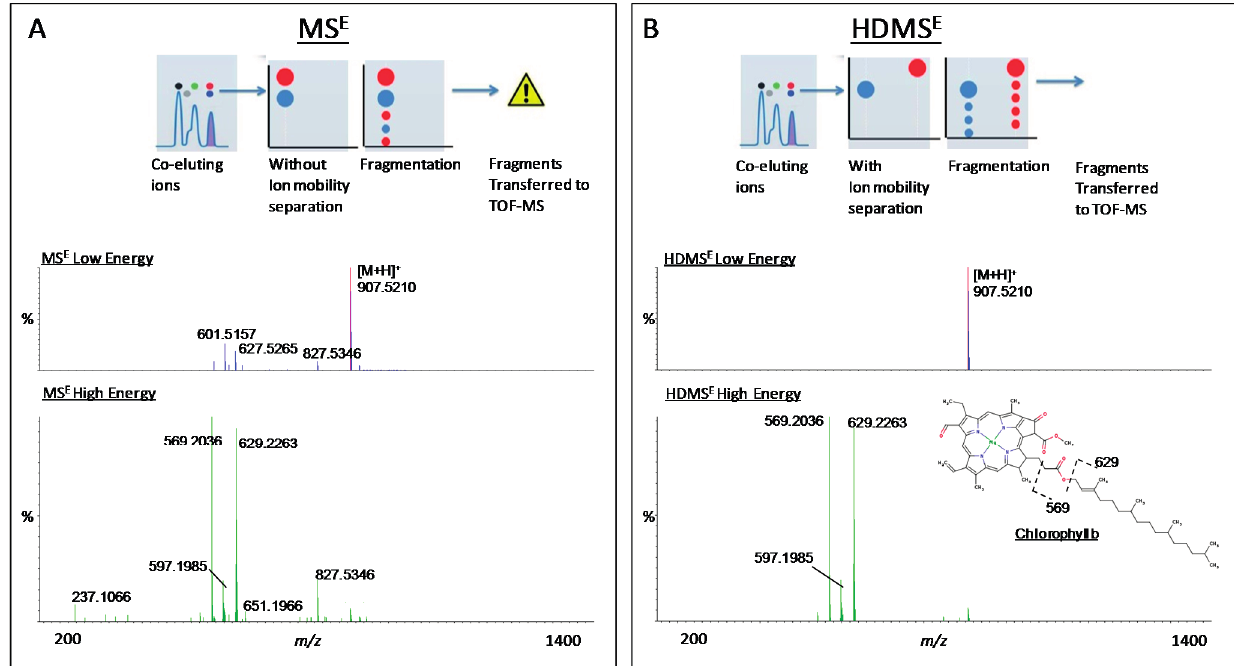
Figure 3. Representative MS E ( A ) and HDMS E ( B ) acquisitions of both precursors and fragment spectra information along one single chromatographic run. Applying high collision energy in the transfer collision cell, precursor molecules can be broken down into constituent parts (product ions), to deduce the original structure (bottom panel). To help identify complex mixtures of metabolites, the identification of the chlorophyll b structure was based on the observation of characteristic fragments generated with high energy after ion-mobility separation using (HDMS E ). The inclusion of an ion-mobility separation of co-eluting precursor metabolites by HDMS E produced cleaner product ion spectra compared to MS E , which facilitated the identification of chlorophyll b by searching against databases and previously published results